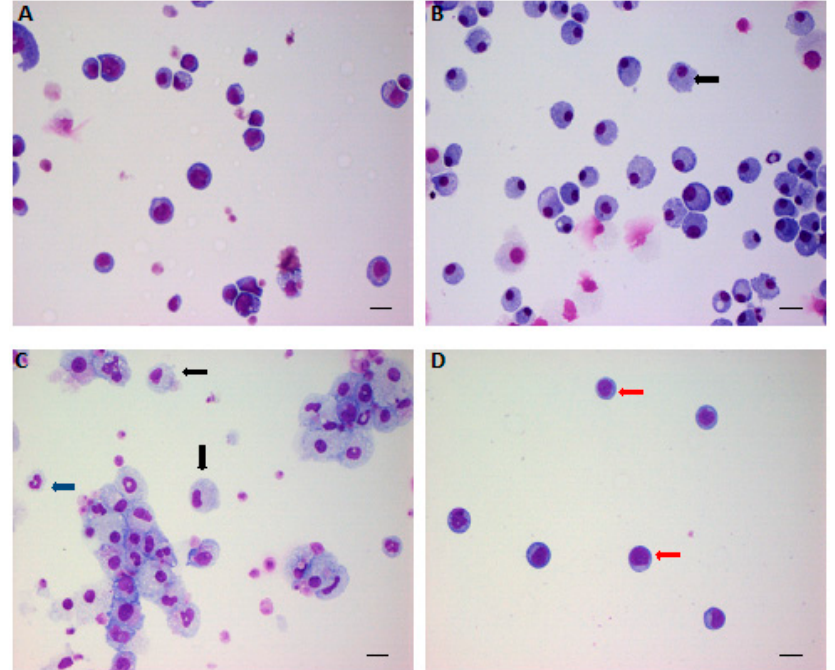
Figure 1. The effects of low-density lipoprotein (LDL) and high-density lipoprotein (HDL) on hematopoietic stem/progenitor cell (HSPC) expansion and differentiation. Lineage - Sca-1 + cKit + cells were sorted out by fluorescence-activated cell sorting (FACS) and cultured in serum-free medium in the presence of BSA ( A ); granulocyte-macrophage colony-stimulating factor (GM-CSF) ( B ); or LDL ( C ); and LDL plus HDL ( D ) for 14 days and then collected by cytospin for Giemsa staining. Red arrow indicates quiescent HSPC; black arrow indicates promonocytes; blue arrow indicates granulocytes. Scale bar: 20 μ m. Adapted from Feng et al, PLoS ONE 2012.